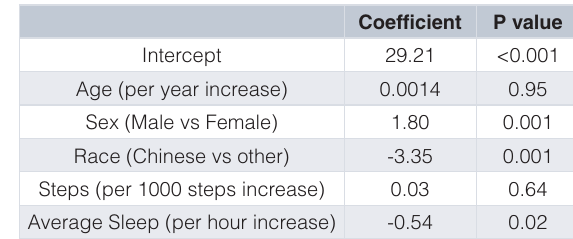
Table 2. Multivariable linear regression analysis results for body mass index